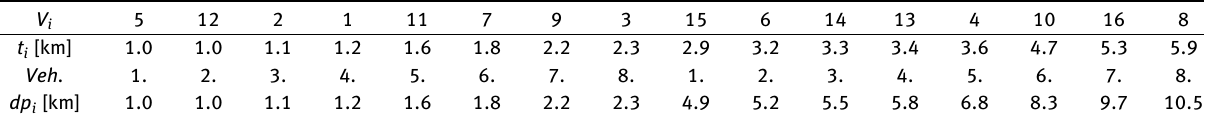
Table 10: The dpi parameter based on sorted distances between V 0 and Vi for eight delivery vehicles V i